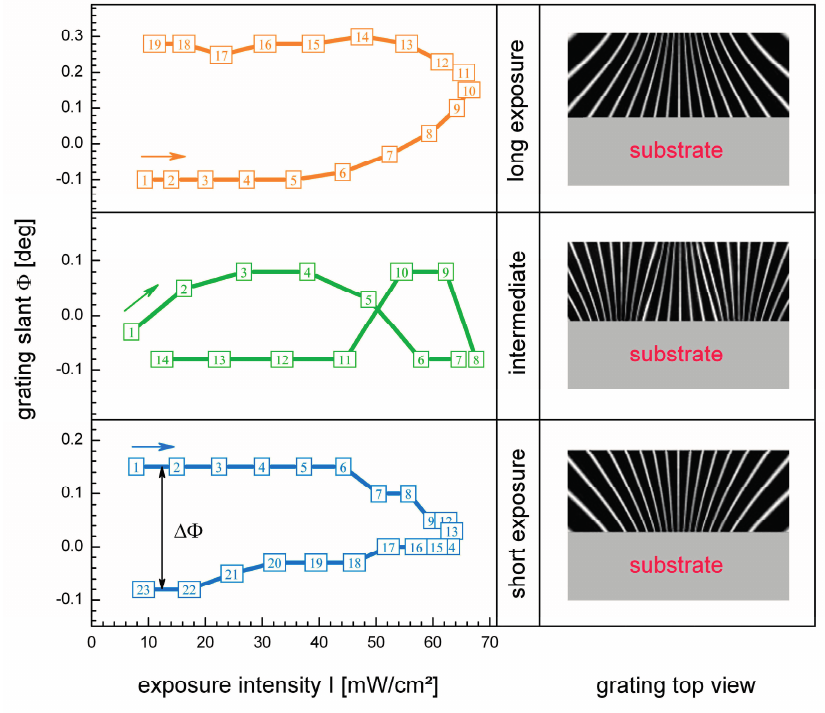
Figure 3. Lateral progressions of the grating slant Φ ( I ), derived from lateral scans from the left to the right ( left side ), numbers indicate the individual, sequentially performed rotation scans; plus corresponding schemes with respect to the orientation of the lattice planes ( right side ). In the case of short exposure duration (lowermost, blue curve) the slant angle changes from positive to negative values, with the result of decreasing grating pitch towards the